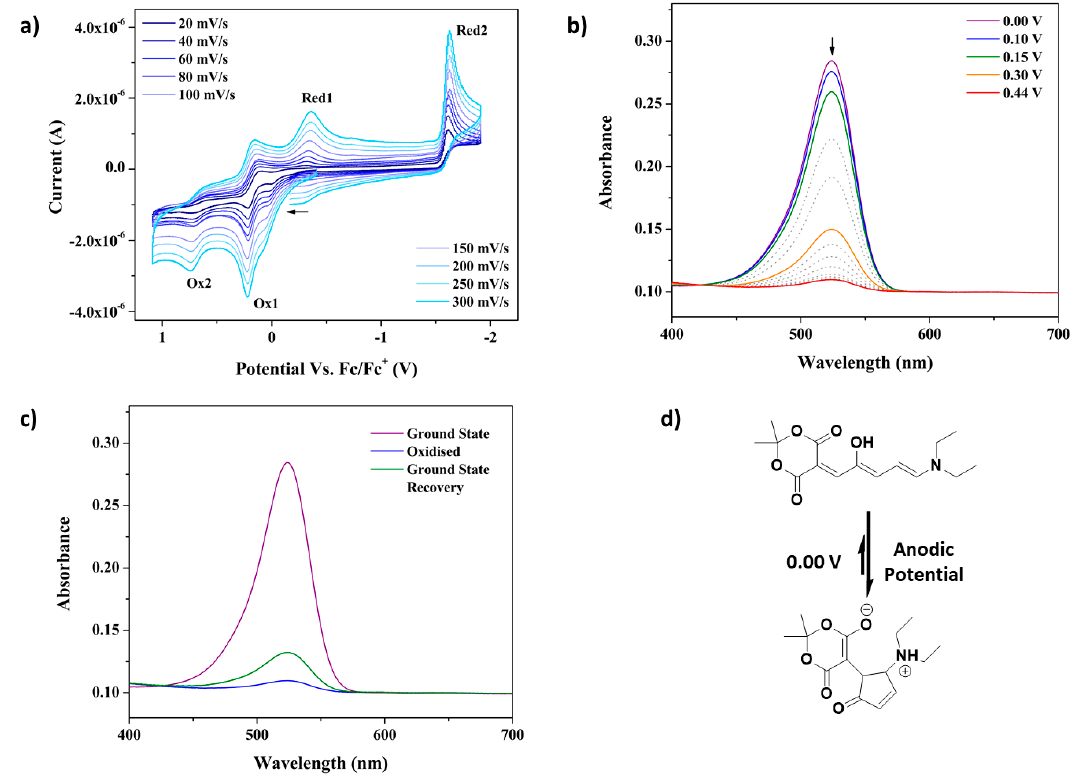
Figure 2. CV recorded at 20–300 mV/s scan rates ( a ); UV-vis SEC spectra from 400–700 nm (14250–25750 cm − 1 ) ( b ); UV-vis spectra following SEC indicating recovery of the linear isomer in the same range (arrow shows the direction of change) ( c ); and proposed quasi-reversible cyclisation in response to an anodic redox potential ( d ) for compound 1 . Electrochemical experiments were conducted in 0.1 M TBAPF 6 in MeCN.